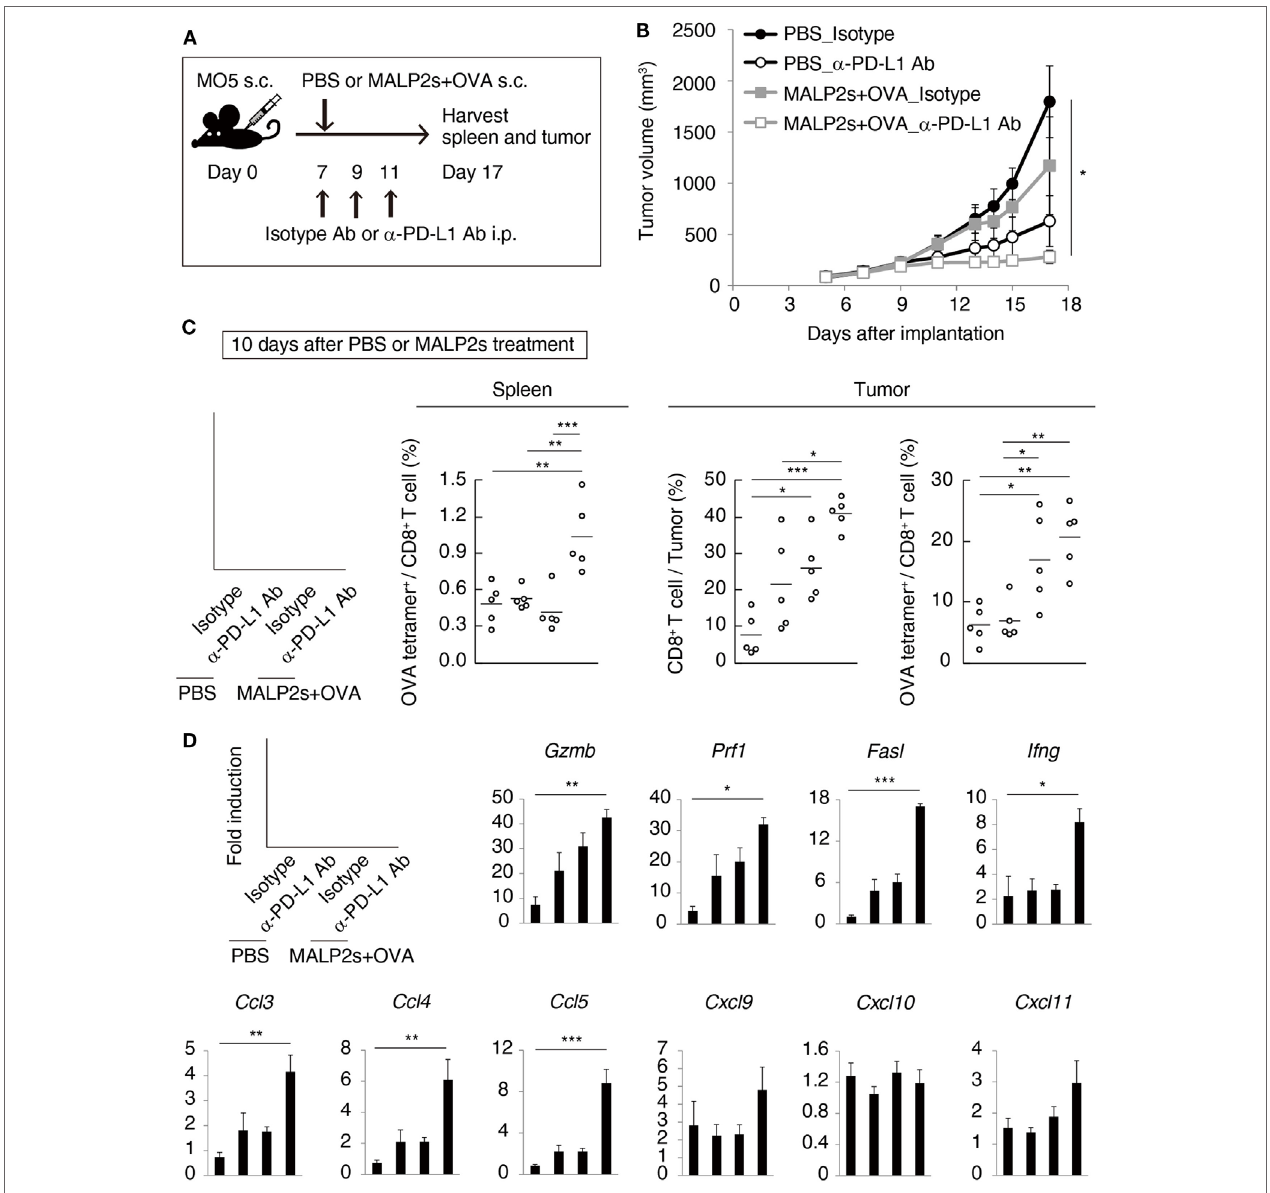
FigUre 5 | MALP2s with tumor-associated antigen enhances antitumor response by programmed death ligand-1 (PD-L1) blockade. (a) The scheme of each treatment on MO5-bearing mice is shown. (B) A tumor volume was measured in each group. (c,D) Mice were euthanized on day 17. (c) The percentages of tumor-infiltrating CD8 + T cells and splenic and intratumor OVA-specific CD8 + T cells were analyzed by flow cytometry. (D) Gene expressions in tumor tissue were analyzed by qPCR. Error bars show ± SEM; n = 5 per group. Kruskal–Wallis test with Dunn’s multiple comparison test or One-way analysis of variance with Bonferroni’s test was performed to analyze statistical significance (* p < 0.05, ** p < 0.01 *** p <